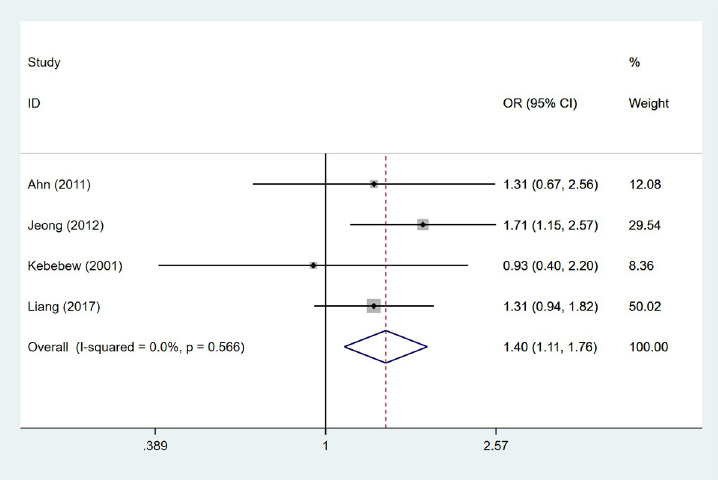
Fig 7. The forest plot of AMES stage-low risk between HT group and non-HT